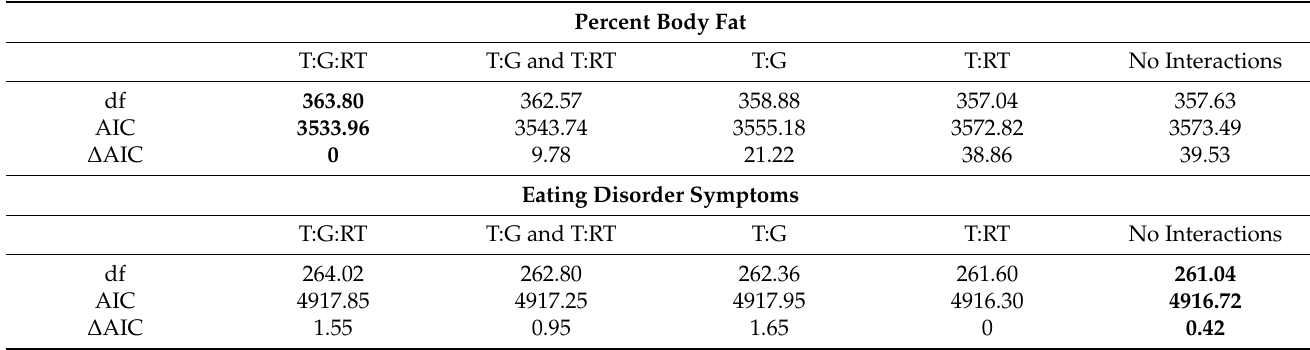
Table 2. Akaike Information Criteria (AIC) for Candidate Models by Outcome.